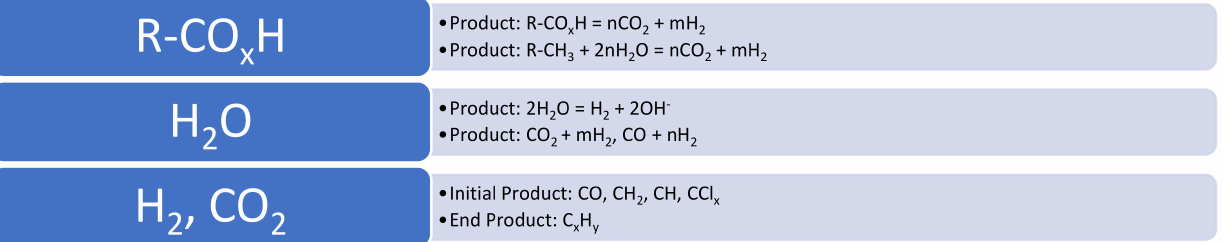
Figure 1. Simultaneous reaction functions of the ZVI in this